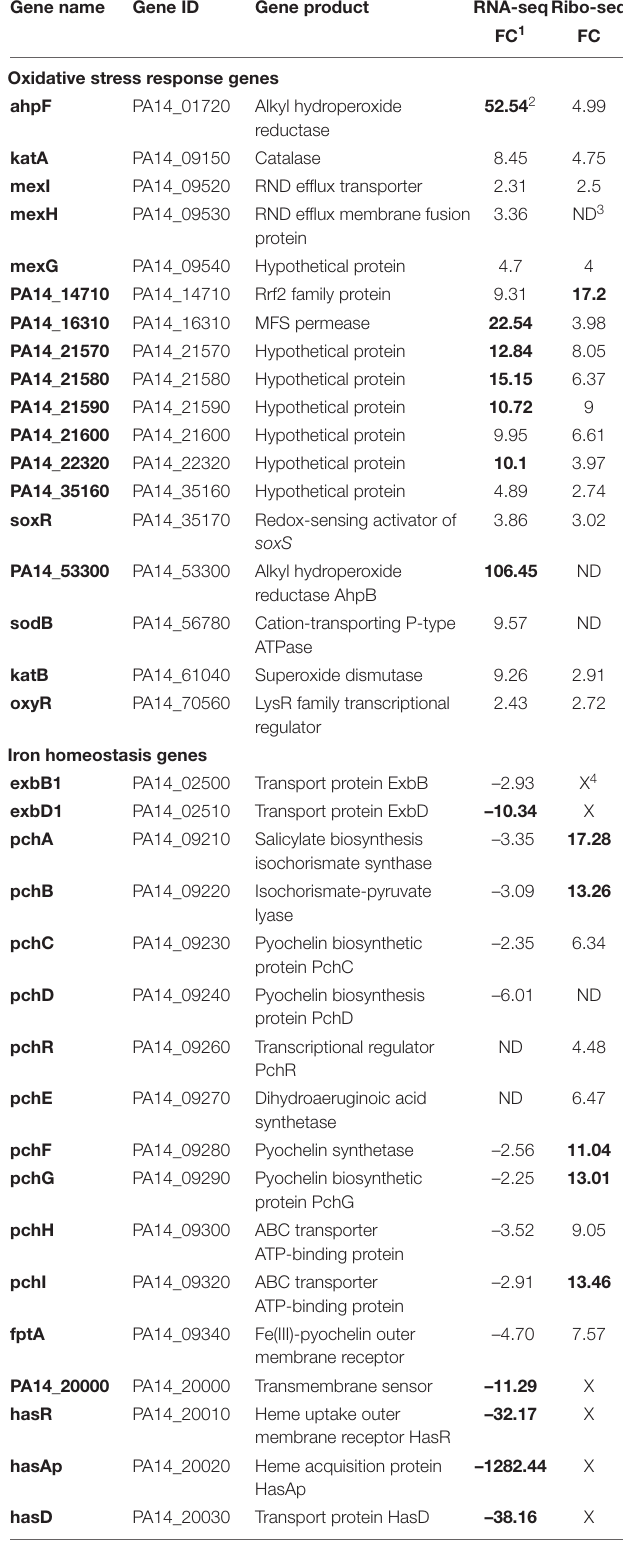
TABLE 1 | Gene expression response of PA14 grown in the presence of colistin versus untreated